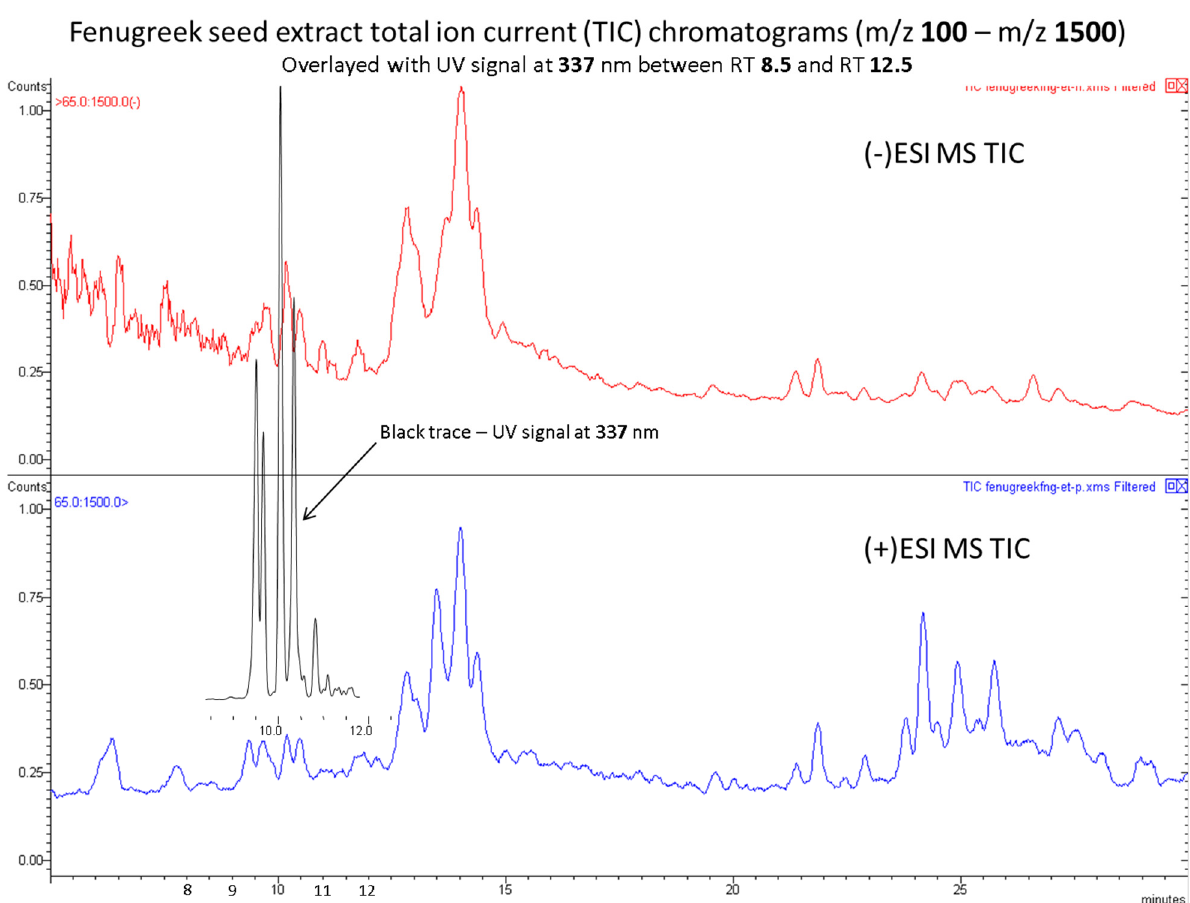
Figure A2. Total ion current LC/MS chromatograms (positive and negative ionization) of Ethanolic Fenugreek Seed Extract.The TIC chromatograms of the fenugreek extract are shown in Figure A2 and characterized by many peaks that were not visible in the UV chromatogram. The peaks between 12.5 min and 16 min appear to be di-through hepta-saccharides of furo-/spirostanol (trigonellosides, trigoneosides, etc.) derivatives based on their lack of absorbance signal at 254 nm, or higher, and their corresponding masses*. *Compounds’ masses and plant species cross-reference searches were made with www.reaxys.com database (Elsevier, RELX group). Samples in Figures A1 and A2 were analyzed by a UPLC/MS system including the Dionex ® UltiMate 3000 RSLC ultra-high pressure liquid chromatography system and a Varian 1200L triple quadrupole mass detector with Varian’s MS Workstation, v. 6.41, SP2.